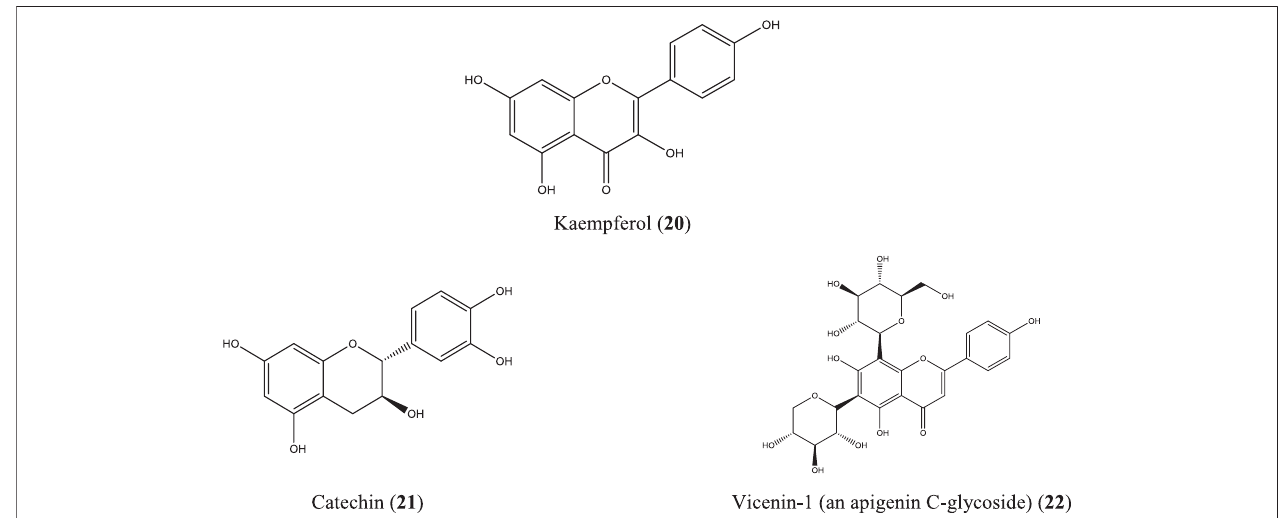
FIGURE 7 | Anti-in fl ammatory compounds isolated from M. paniculata .